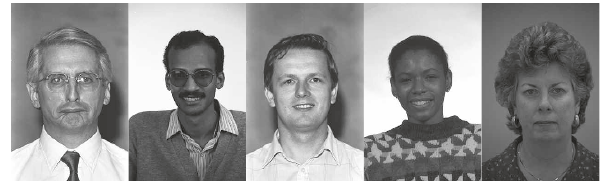
Figure 11: Sample images from the FERET